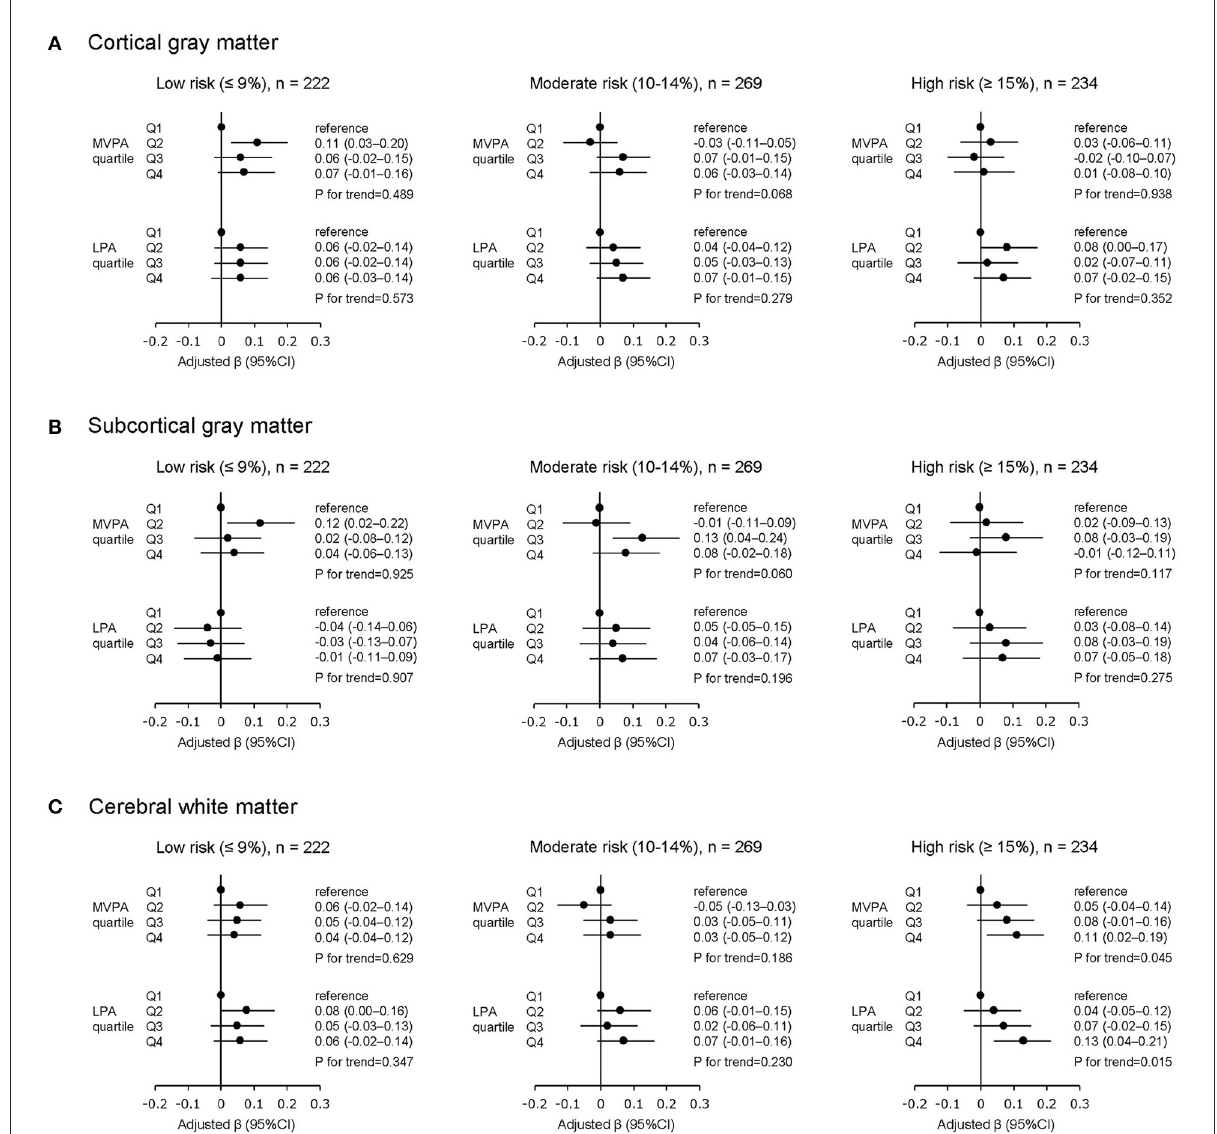
FIGURE3 Physical activity and brain volume stratified by absolute cardiovascular risk levels. (A) Cortical gray matter, (B) subcortical gray matter, (C) cerebral white matter. MVPA, moderate- to vigorous-intensity physical activity; LPA, low-intensity physical activity; Q, quartile of physical activity as an independent variable; CI, confidence interval. All β values are adjusted by age, sex, education level, and total cranial volume. All P values are corrected for multiple testing using the Benjamini-Hochberg with false discovery rate set to